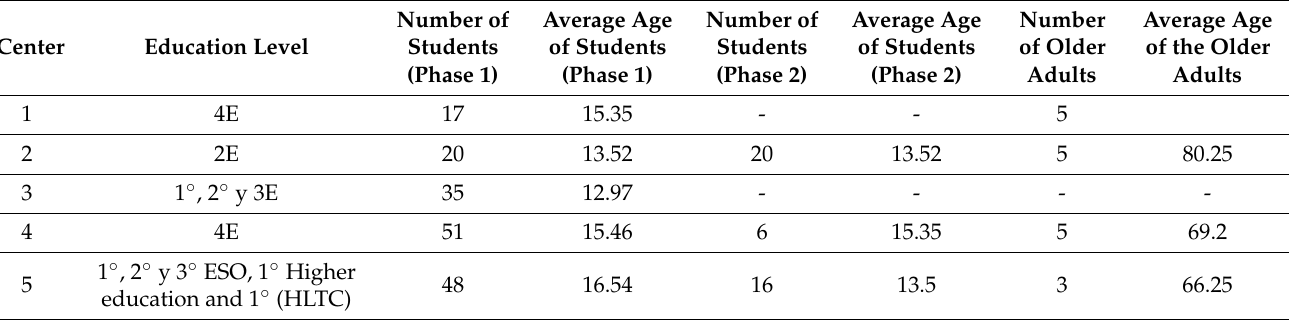
Table 1. Participants (academic year 2020–2021).